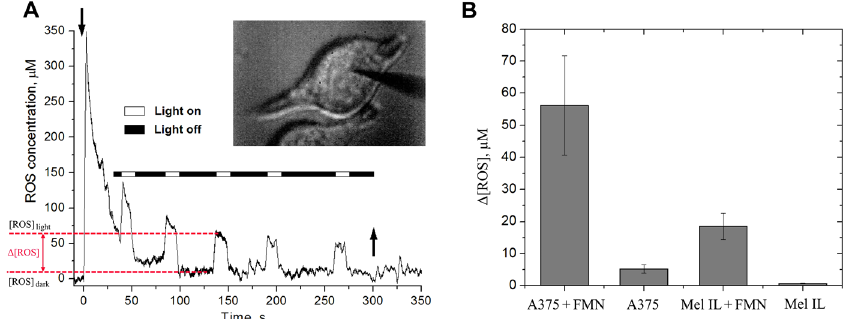
Figure 3. Electrochemical probe of ROS in melanoma cells: the measurement of ROS generated within A375 melanoma cells after pre-incubation with 100 µ M FMN ( A ). Dark scale is for light off, white scale is for light on. The moments of electrode insertion into the cell and withdrawal from the cell are depicted with downward and upward arrows, respectively; the image of nanoelectrode inserted into the cell is in the upper right corner. The changes in ROS level under light irradiation were calculated according to the following formula: Δ [ROS] = [ROS] − [ROS] Δ [ROS] measured inside blue-light irradiated A375 and light dark . The comparison of Mel IL melanoma cells, both FMN pre-incubated and control ones ( B ). Data are the mean ± SE, N = 5 for FMN- incubated cells and N = 3 for control